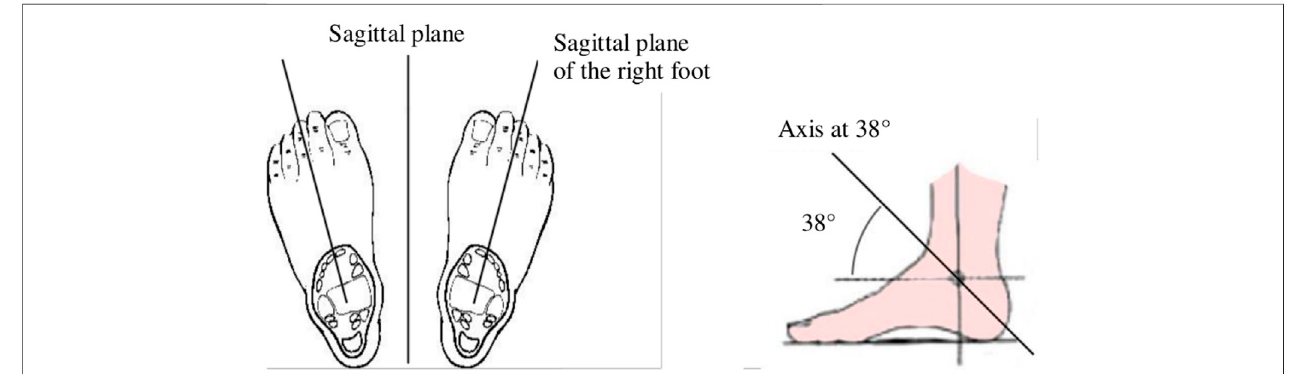
FIGURE 5 | De fi nition of the subtalar